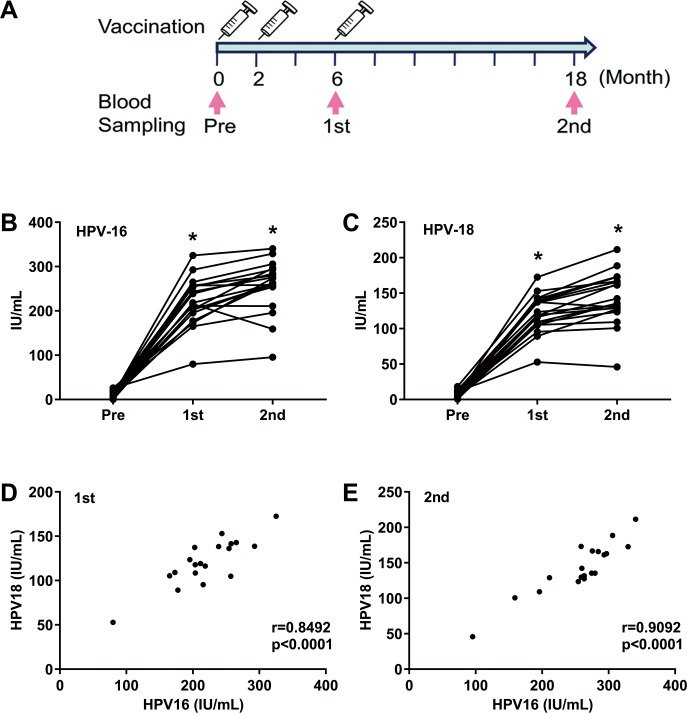
Change in HPV-16/-18 Ab levels after vaccination.A. A schema of the vaccination and blood sampling protocol. HPV vaccination (Gardasil®) was provided at 0, 2, and 6 months, and blood sampling was conducted at 0 (pre), 6 (1st), and 18 (2nd) months. B and C. The change in serum HPV-16 (left) and HPV-18 (right) Ab concentrations of each subject was observed at the 1st and 2nd time-point. Asterisk (*) represents p < 0.001, one-way ANOVA. D and E. Correlation between anti-HPV-16 Ab (x-axis) and anti-HPV-18 Ab (y-axis) at 1st (6 months, left) and at 2nd (18 months, right) collection time points.